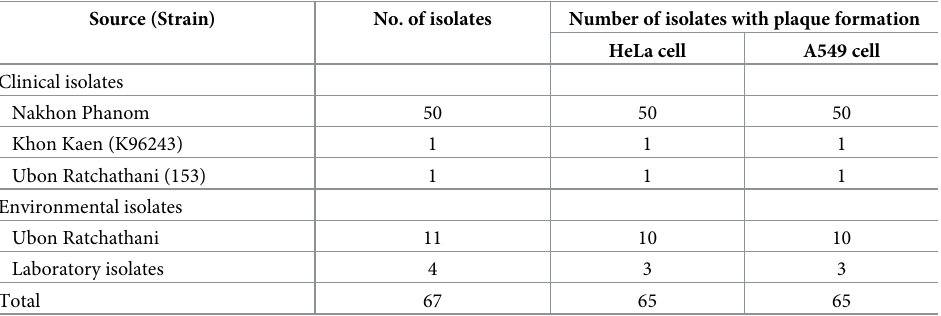
Table 1. Plaque formation of clinical and environmental isolates of B . pseudomallei in A549 and HeLa cells. Source (Strain)